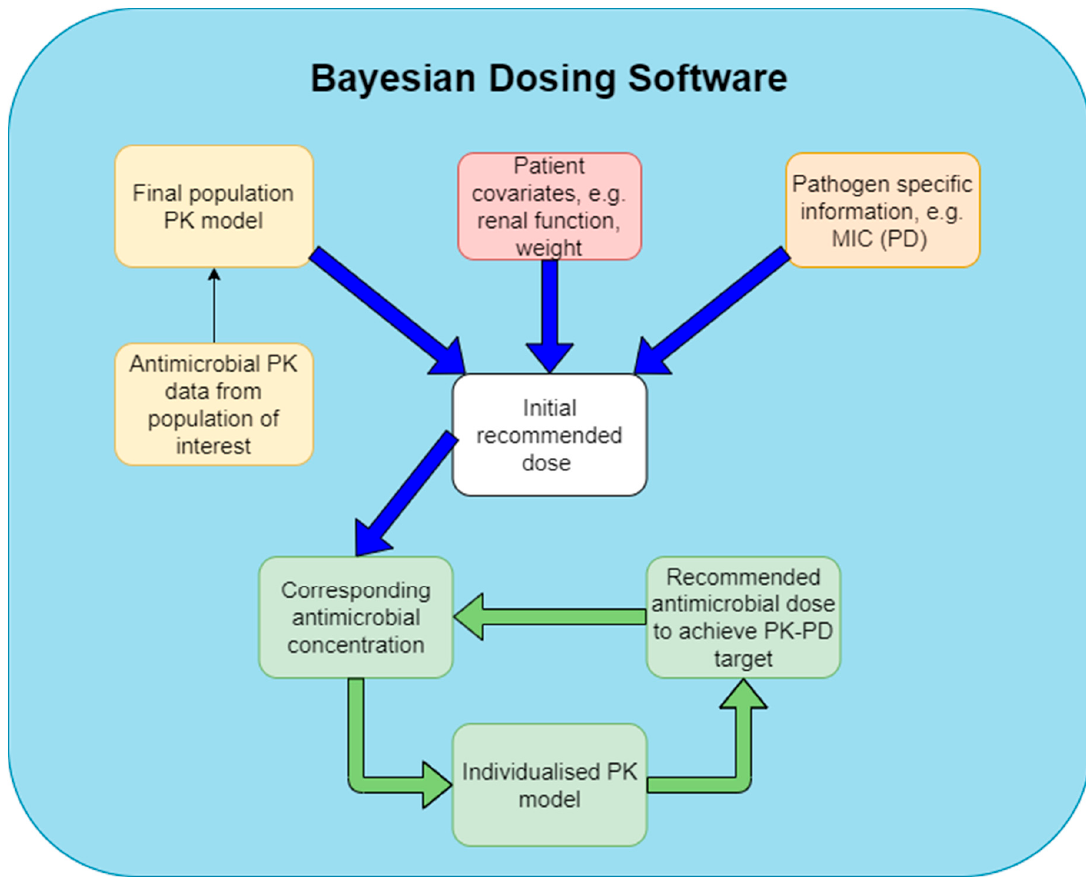
Figure 3. Bayesian forecasting based dosing software (blue) initially utilises patient covariates (red), PK properties of the antimicrobial (yellow), and pathogen PD properties (orange) to generate an initial recommended dose that is likely to achieve the PK-PD target associated with maximum efficacy. Resulting plasma exposure concentrations from this dose can then be used to produce a refined PK model that is individualised to a specific patient. A new optimised dose is then produced that is specific to the patient and can be further refined if needed with additional TDM data (green cycle).